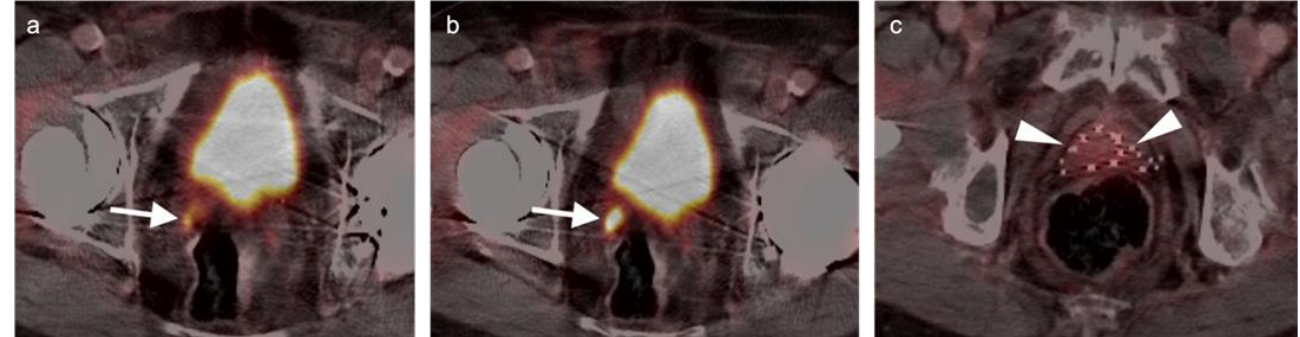
Figure 27. Diagnostic value of PSMA PET-CT detecting extra-prostatic recurrence in the face of metal artifact. ( a , b ) There is prostate cancer recurrence in the right seminal vesicle (white arrows), identified despite the presence of bilateral total hip prostheses. A metal artifact reduction algorithm was utilized for the CT; ( c ) Multiple brachytherapy seeds are present (white arrowheads) without obvious recurrence within the prostate.